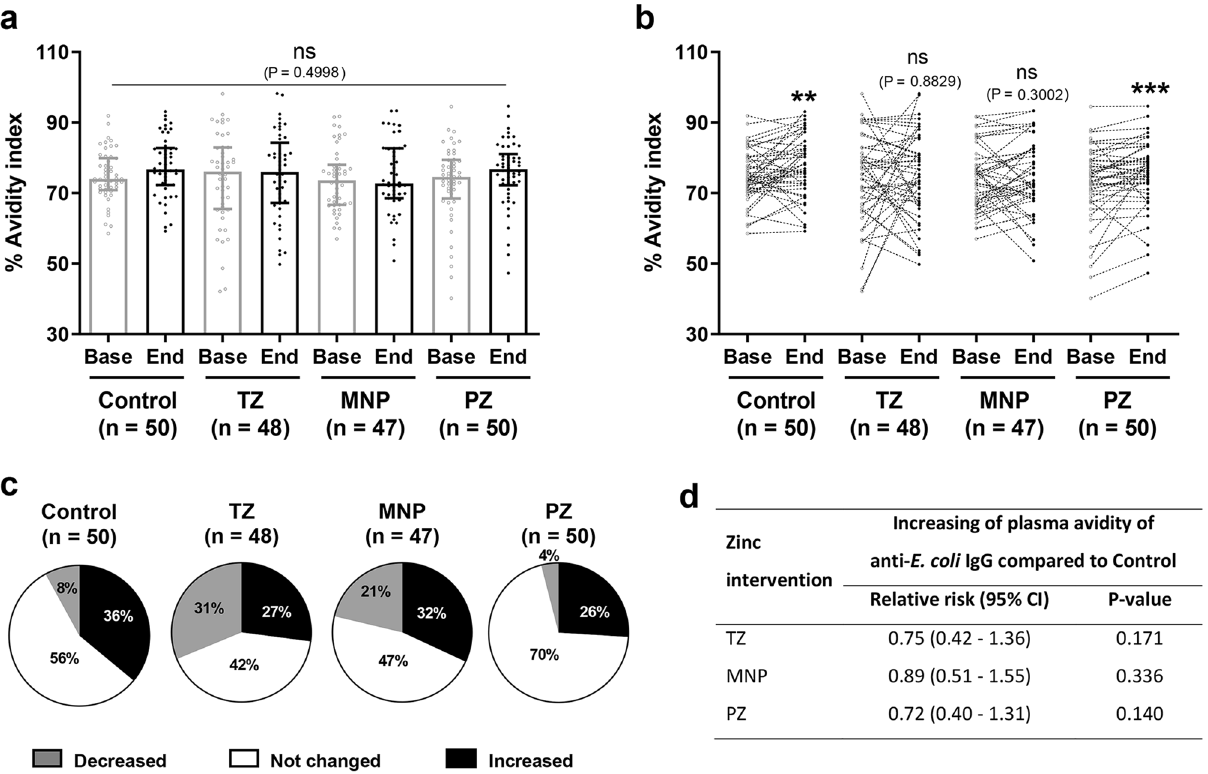
Figure 2. Changes in the avidity index of children among the four intervention groups. ( a ) Plasma samples from baseline and endline of each intervention group (Control, n = 50; TZ, therapeutic zinc with diarrhoea, n = 50; MNP, zinc-containing micronutrient powder, n = 50; PZ, preventive zinc, n = 50) were used to determine the avidity index. Bars represent the median with the interquartile range of each group; each dot represents an individual sample. The P-value was determined with the Kruskal–Wallis test. ( b ) Changes in the avidity index of each individual. The P-values indicate significant differences between baseline and endline of each intervention group determined by the Wilcoxon matched-pairs signed rank test (**P < 0.01; ***P < 0.001; ns non-significant). ( c ) The pie charts show the percentages of children who showed no change or an increase or decrease of at least 5% in the avidity index at endline compared with baseline for each group. ( d ) Chi-square analysis of relative risk and P-values of increasing avidity from each intervention group compared with the Control